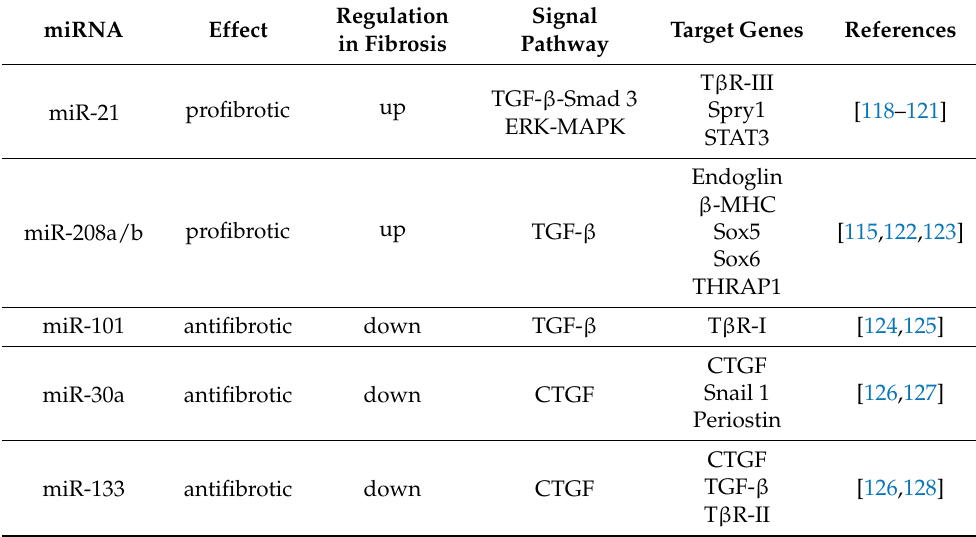
Table 1. miRNA molecules involved in the regulation of the signalling pathways in the process of atrial